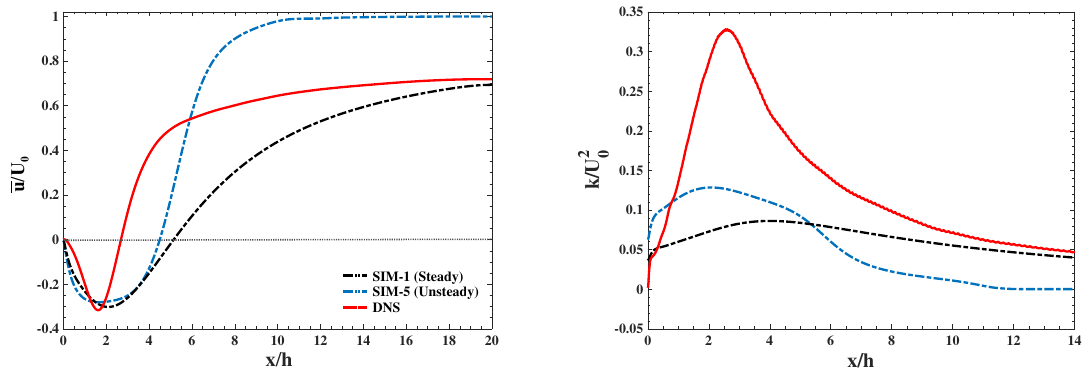
Figure 7. Mean streamwise velocity (left) and streamwise velocity gradient (right) computed by steady and unsteady k − ε and compared to Reference [29].